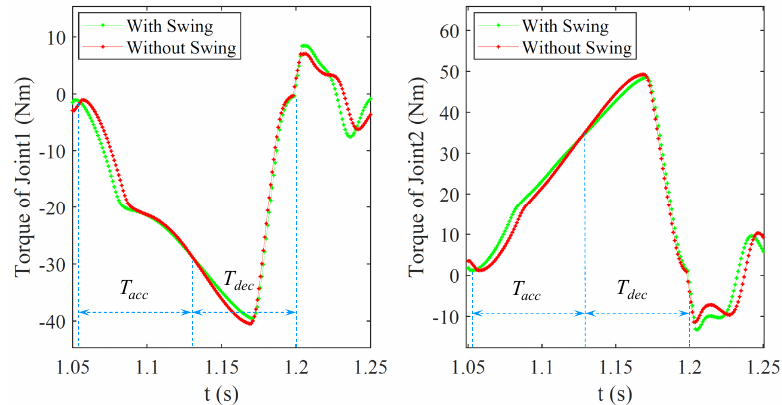
Figure 9. The joint torques the robot leg during the take-off phase.